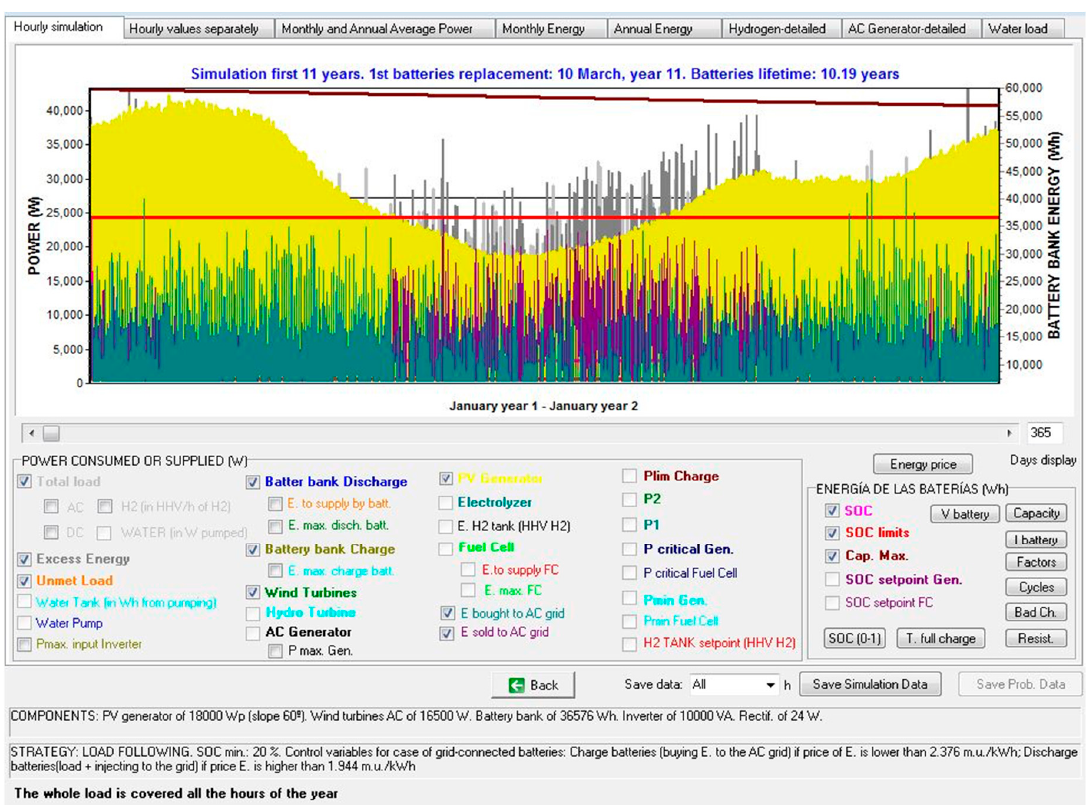
Figure 8. Load following option shown using hourly simulation of the HRES (a screenshot of the system simulation).